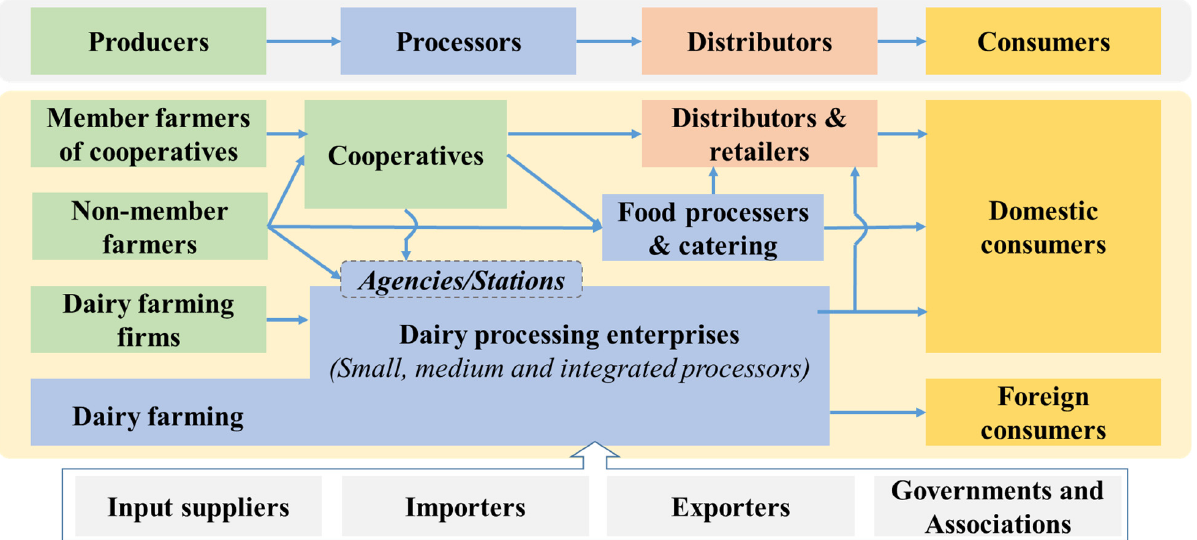
Figure 7. The milk value chain in Vietnam. Source: Authors’ construction based on interviews.